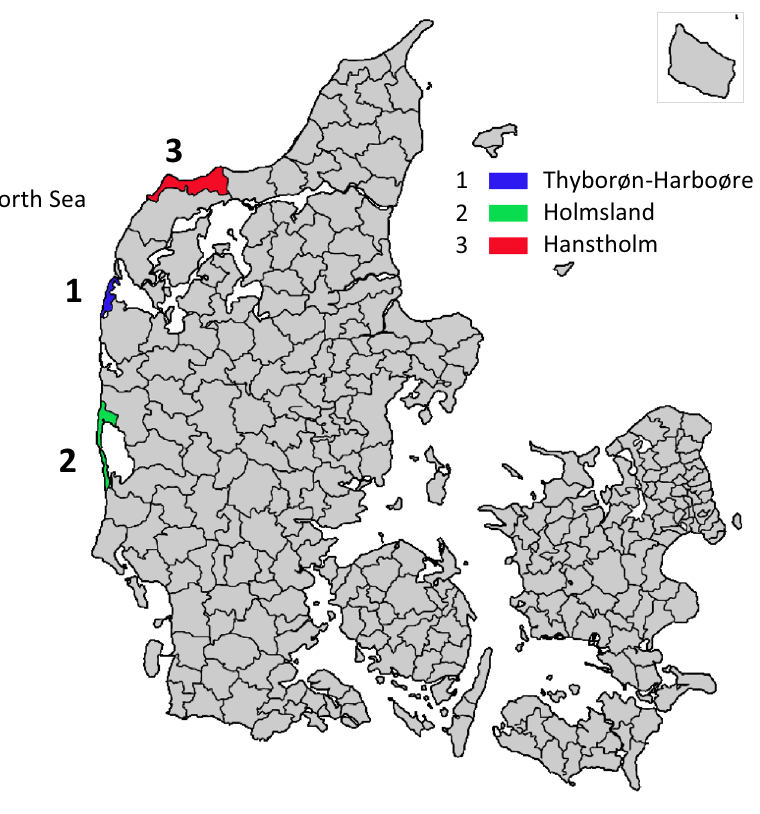
Figure 1. Denmark with the study area Thyborøn-Harboøre and the local control areas Holmsland and Hanstholm